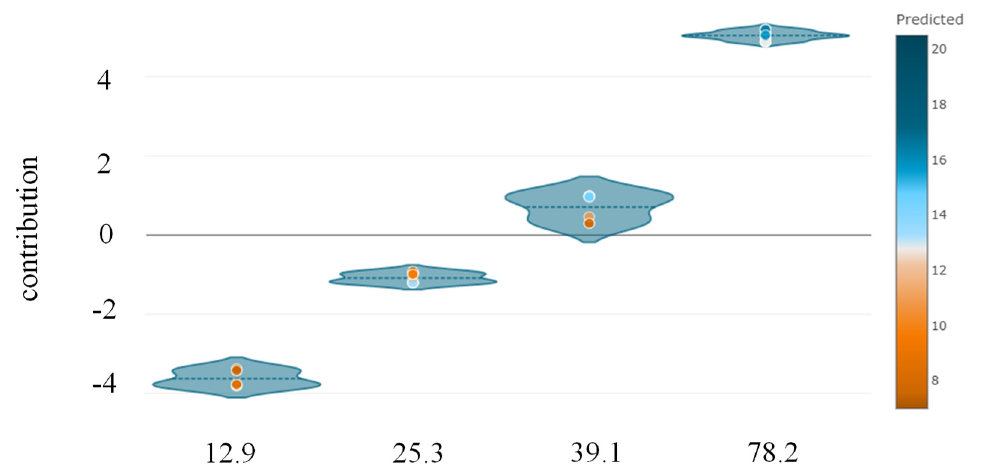
Figure 8. Feature contribution of E f T f towards the target variable.